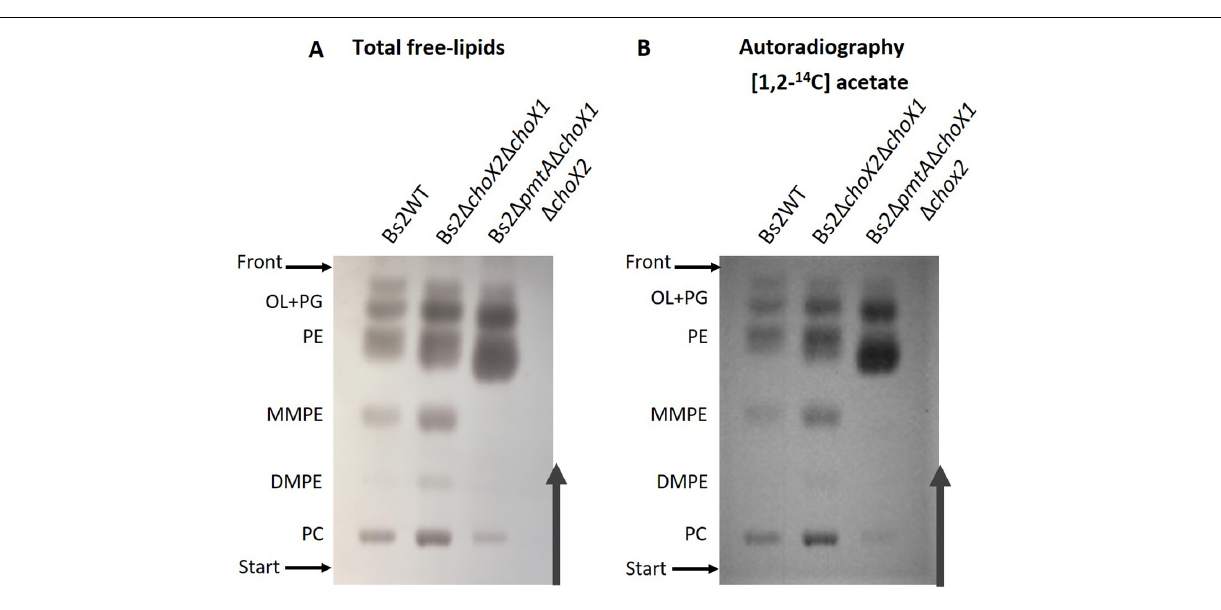
FIGURE 6 | High-performance thin-layer chromatography analysis of Bs2WT, Bs2 (cid:49) choX1 (cid:49) choX2 , and Bs2 (cid:49) pmtA (cid:49) choX1 (cid:49) choX2 after in vivo labeling with [1,2 − 14 C] acetate in mGSM. Total free lipids were revealed by charring (A) or autoradiography (B) . OL, ornithine lipids; PG, phosphatidylglycerol; PE, phosphatidylethanolamine; MMPE, monomethyl-phosphatidylethanolamine; DMPE, dimethyl-phosphatidylethanolamine; PC,